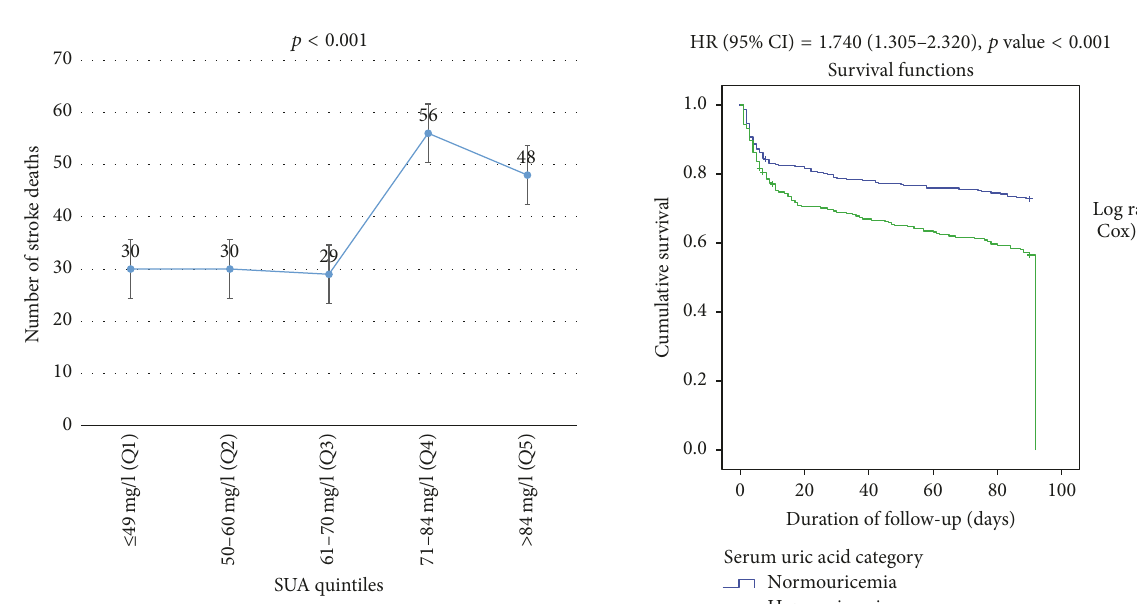
Figure 2: Death rate across SUA quintiles.